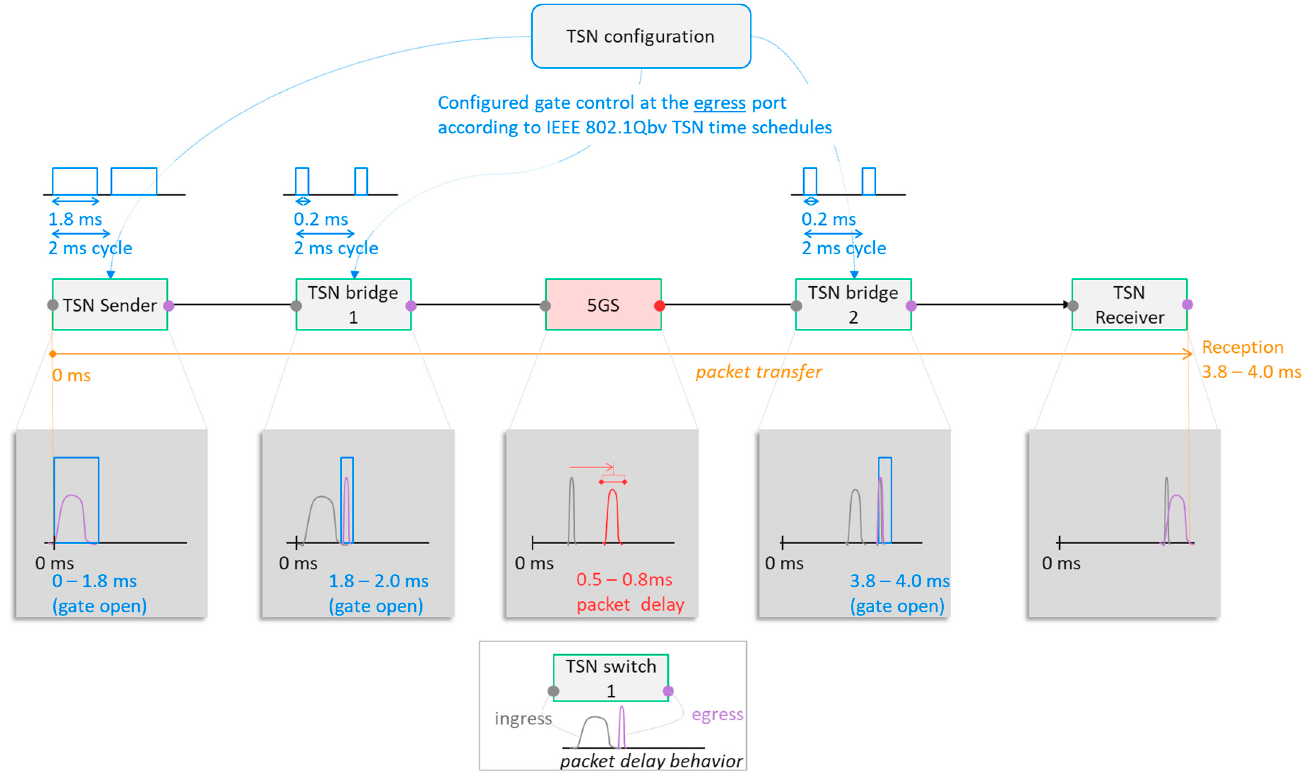
Figure 10. Time shaping carried out in various parts of the setup of 5G integrated with TSN.